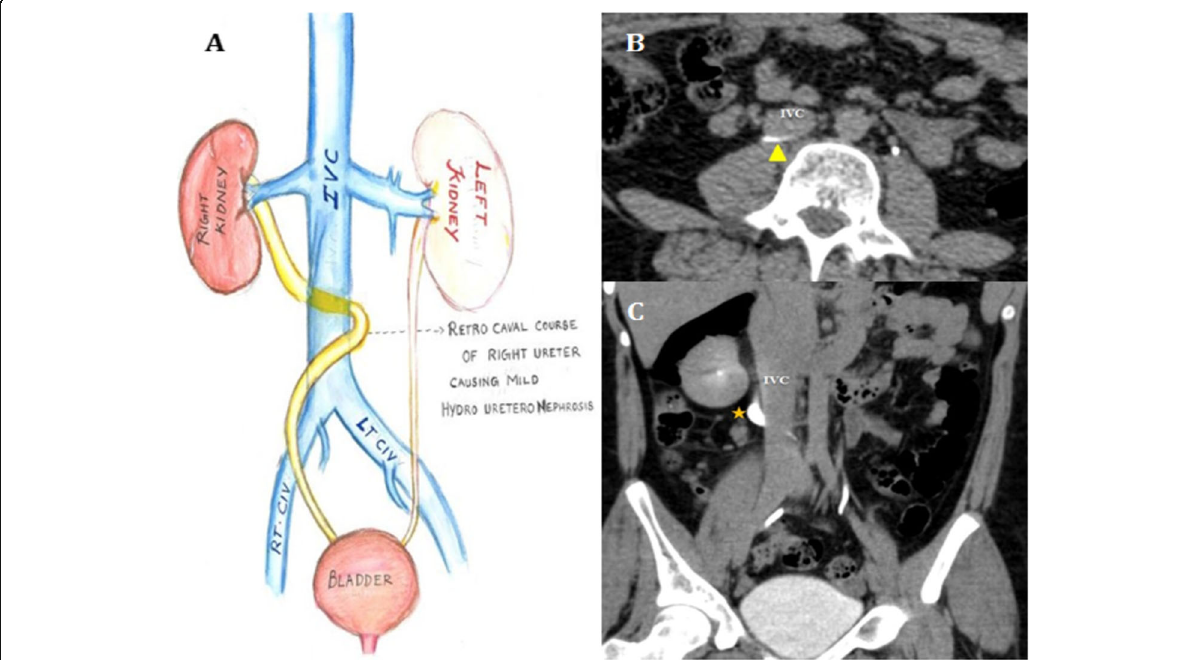
Fig. 10 26-year-old male with retrocaval ureter. ( a ) shows hand diagram in coronal view illustrating the retrocaval course of the right ureter with secondary hydroureteronephrosis. Axial and coronal views ( b and c ) of contrast-enhanced CT study of the abdomen in delayed phase show the compressed ureter (arrowhead and asterisk) in between the inferior vena cava and right psoas. The hand diagram is self-drawn by the